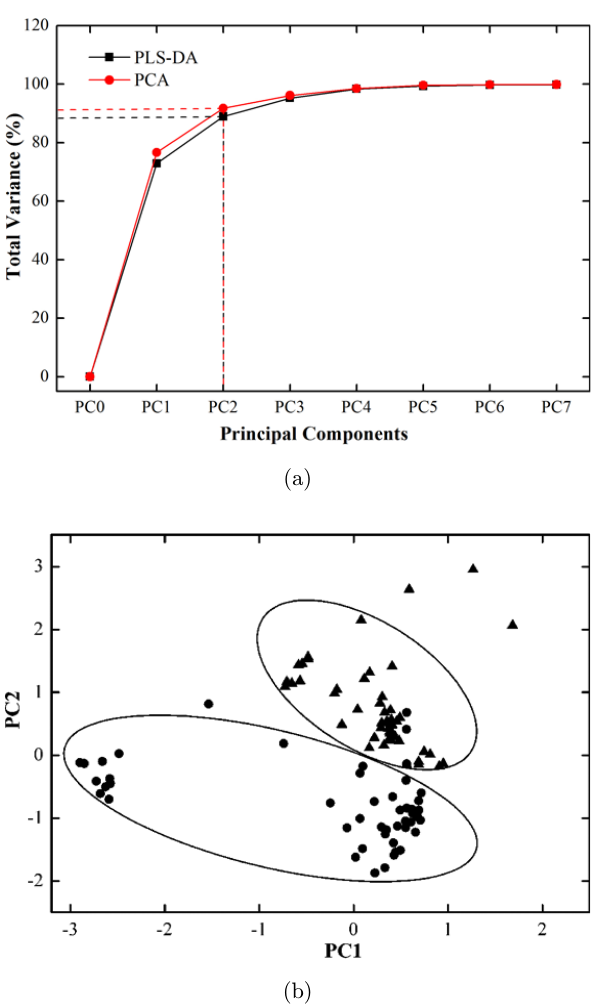
Fig. 2. FTIR images of total absorption images 1072 cm (cid:1) 1 images and visible images of a healthy (a) and an OA (b) cartilage, respectively. The absorption max for total absorption images and 1072 cm (cid:1) 1 images were 1.5 and 2.0, respectively.